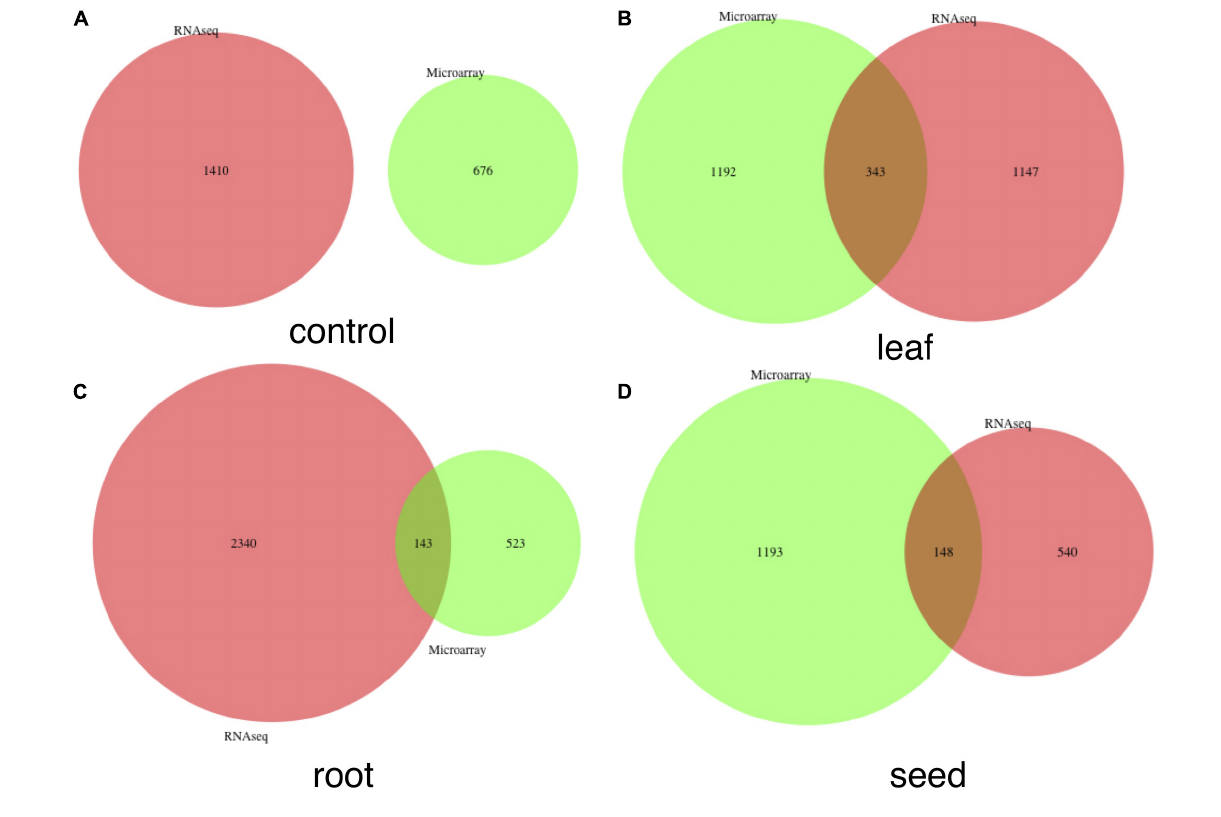
FIGURE 3 | Venn plots of common genes detected in both microarray and RNA-seq data sets without the autoencoder model. These genes were detected directly with the τ index. (A–D) Correspond to numbers of common genes in the control, leaf, root, and seed,